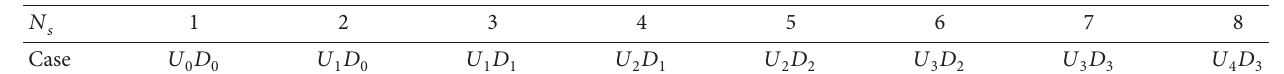
Table 1: The serial number N